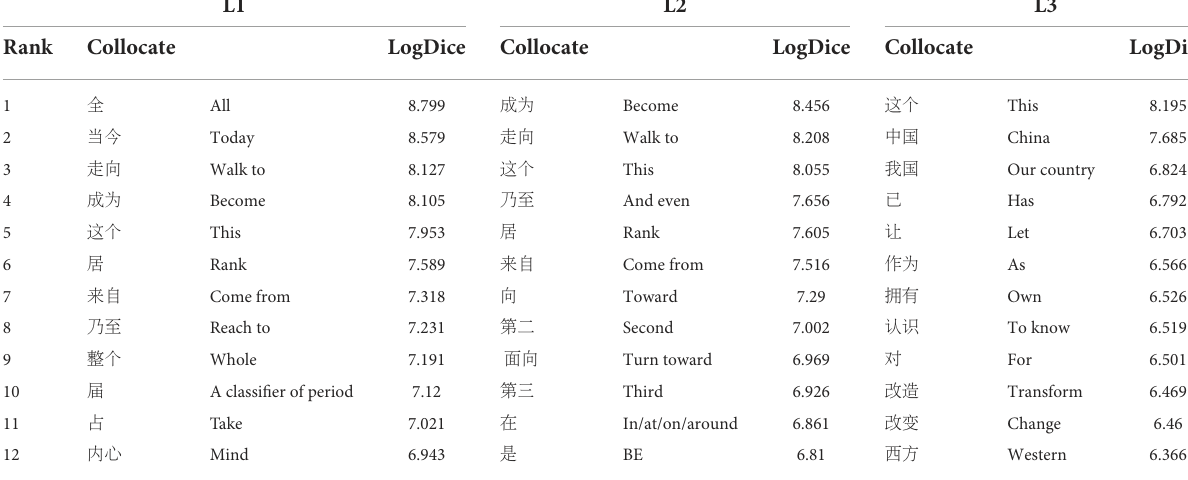
TABLE 1 Left collocates of 世 界 shi4jie4 . L1 L2